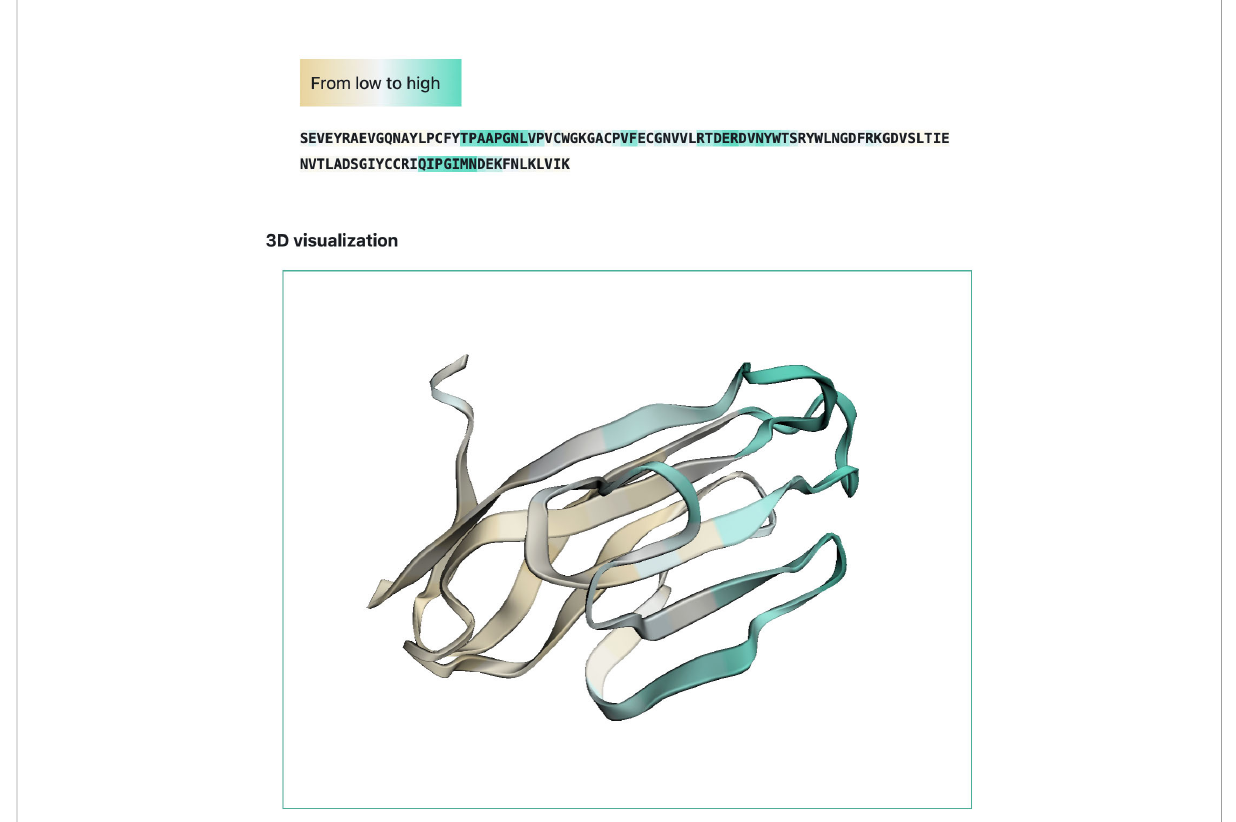
FIGURE 6 Example of SEMA-3D graphical output (PDB ID: 6TXZ, chain D). Residues are colored from brown (non-epitope) to cyan